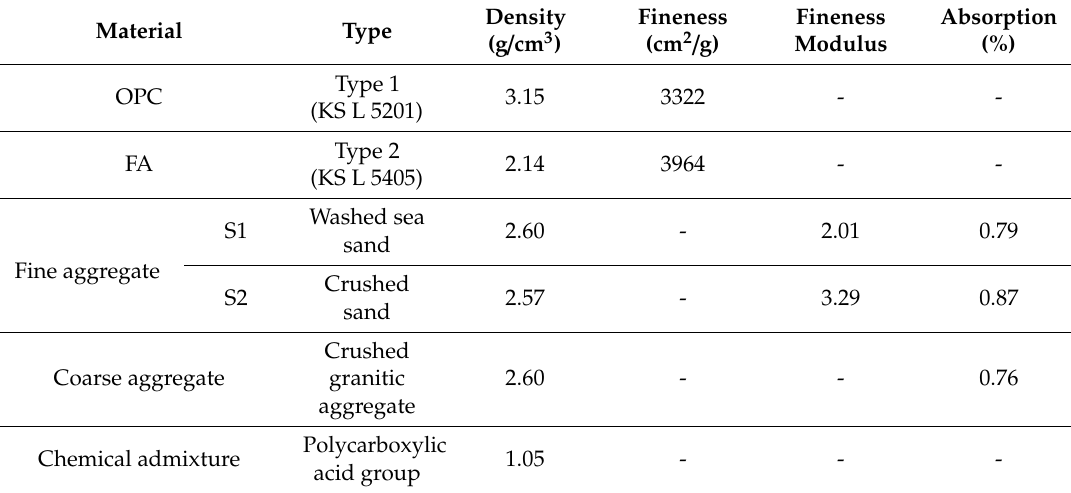
Table 2. Physical properties of the materials